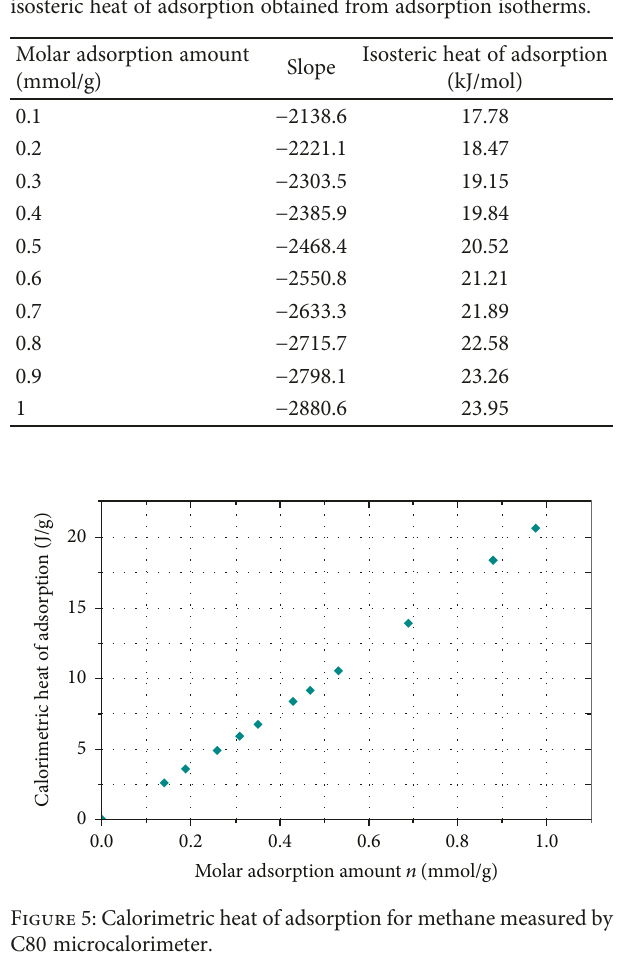
Table 3: Slope of each fi tting line of ln P -1/ T and corresponding isosteric heat of adsorption obtained from adsorption isotherms.